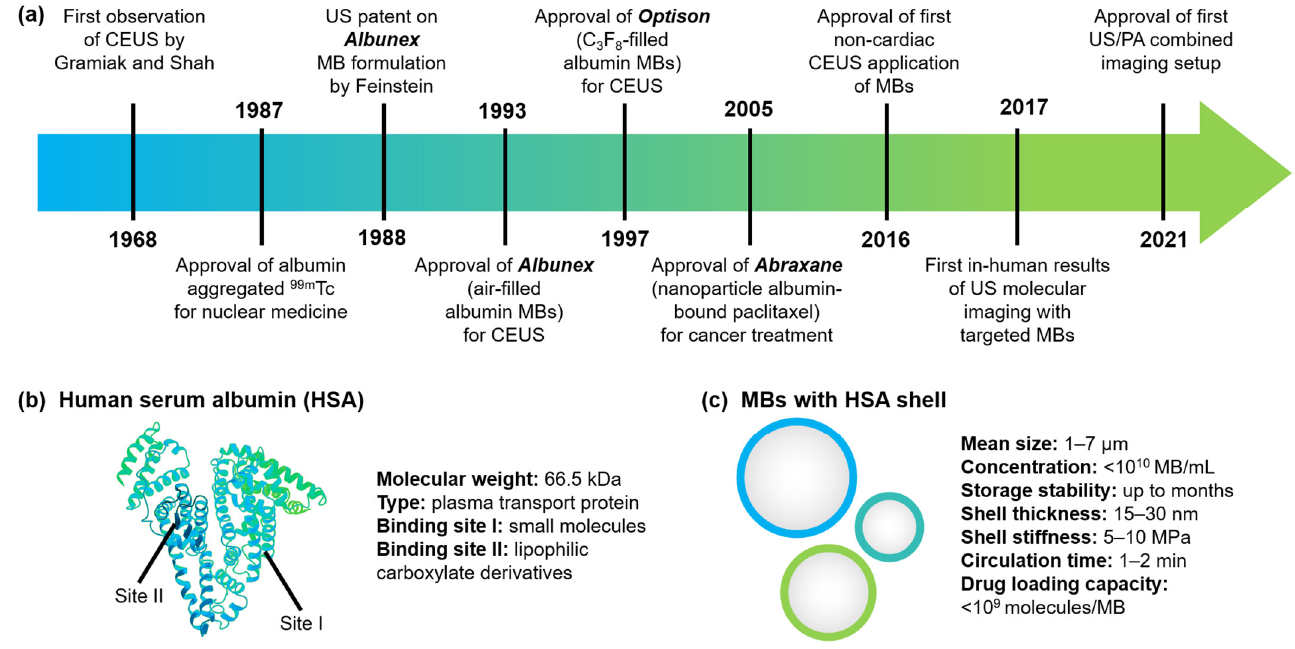
Figure 1. Microbubbles with albumin shell for ultrasound imaging. ( a ) Timeline of key advances in the field of ultrasound (US) contrast agents and albumin-based formulations development; key characteristics of ( b ) human serum albumin (HSA) and ( c ) microbubbles with an HSA shell. Abbreviations: US, ultrasound; CEUS, contrast-enhanced ultrasound; MBs, microbubbles; PA, photoacoustic; HSA, human serum albumin.